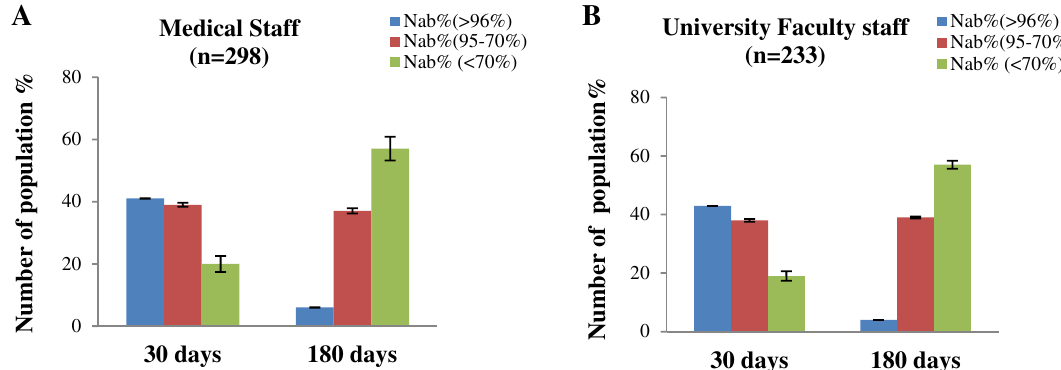
Figure 6. ( A ) After 30 days and ( B ) after 180 days of 2nd vaccination, the percentage of participants with an immune response in the Medical Staff and University Faculty Staff group.